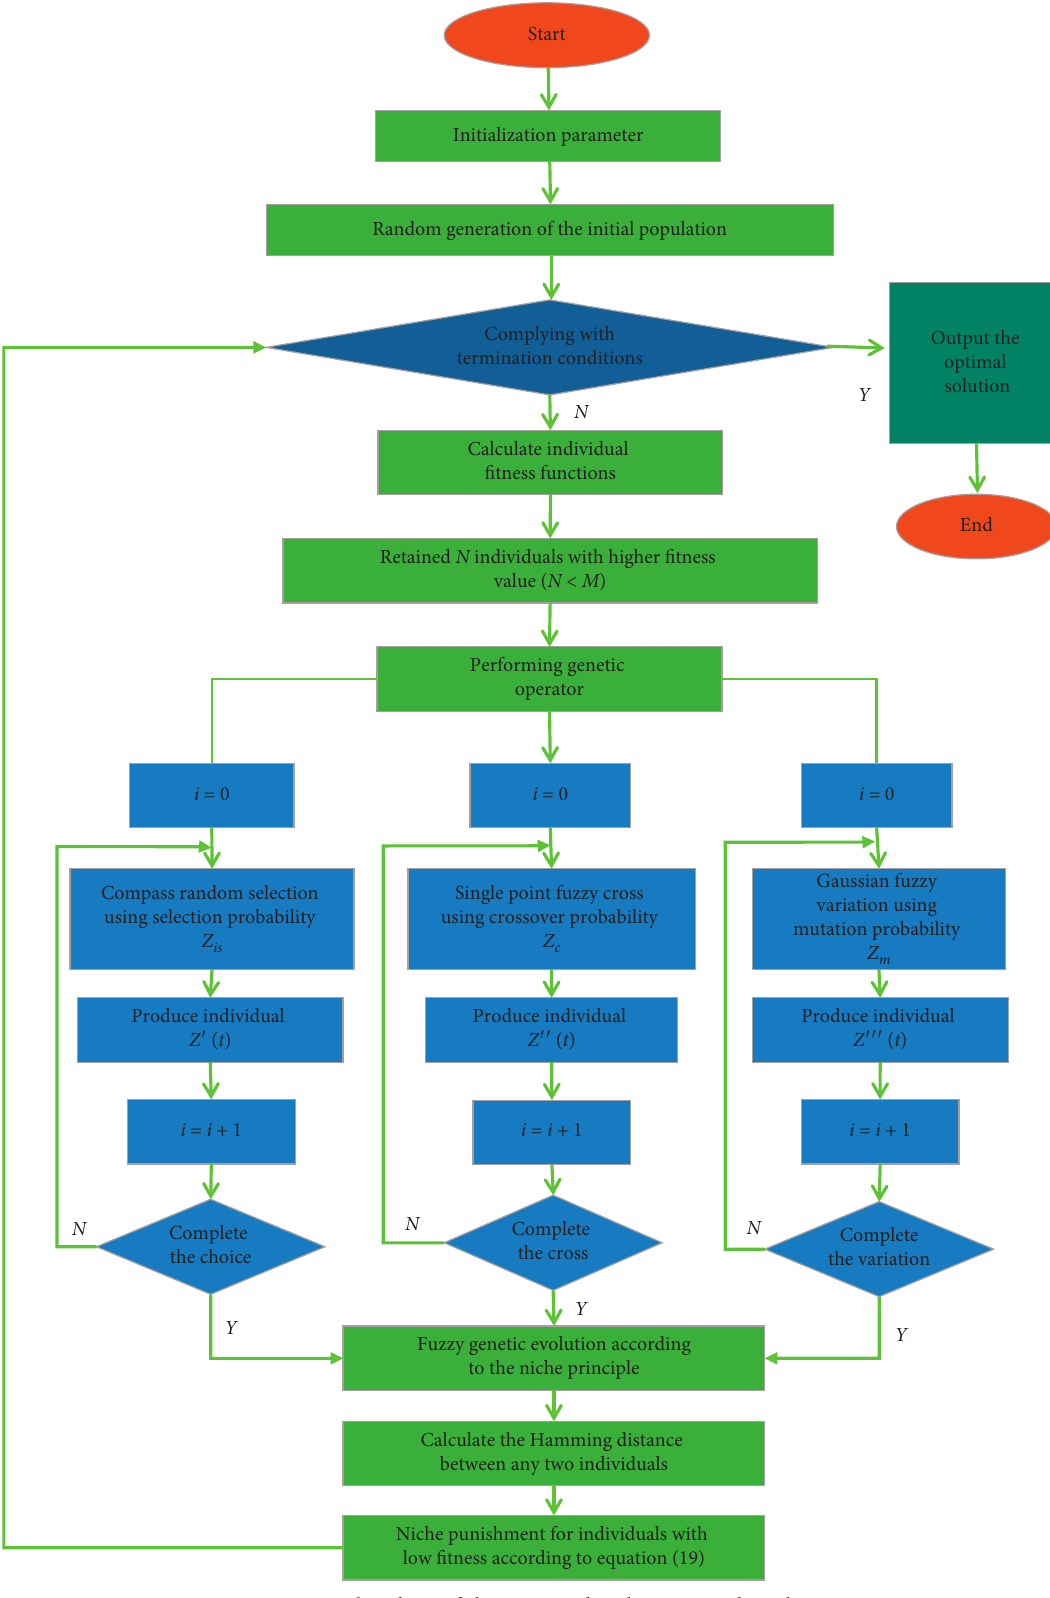
Figure 2: Flowchart of the improved niche genetic